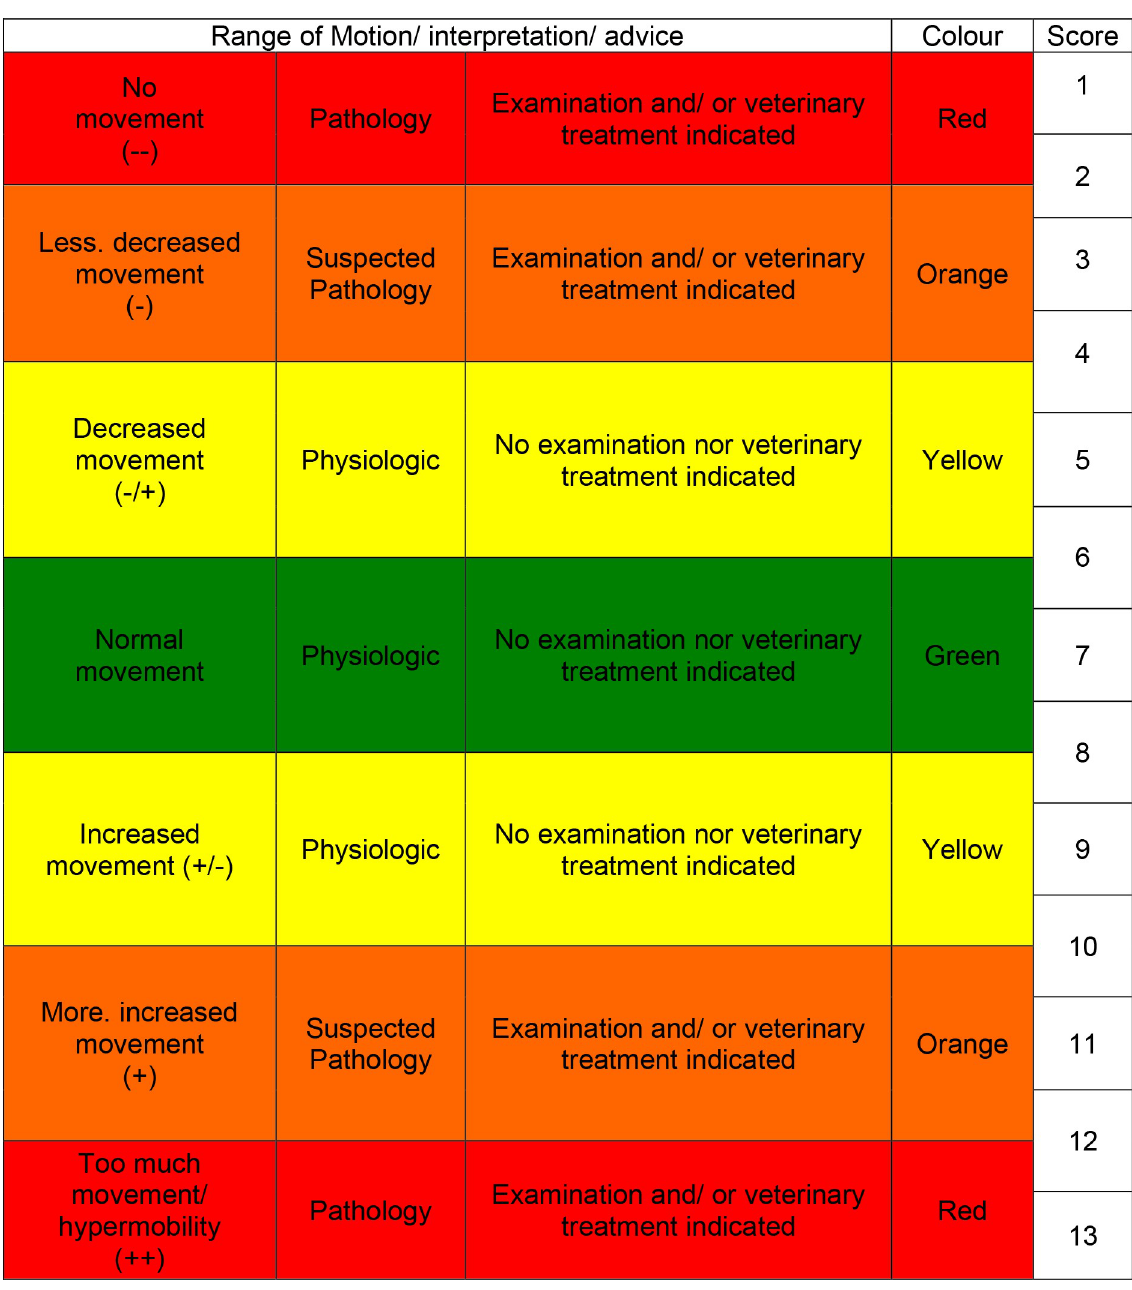
Fig 3. Colour scheme used to grade back mobility on a 1–13 scale associated with range of motion. The interpretation of the grades is given in terms of existence of pathology and in clinical terms with respect to the need to take action. https://doi.org/10.1371/journal.pone.0252536.g003 observer rated the mobility as slight aphysiological, 2 and 12 and moderate aphysiological and 1 and 13 as severe aphysiological (S1 Fig). Only one box per parameter could be ticked. Nine parameters of back mobility were evaluated: general mobility (GenMob), thoracic flexion (ThorFlex), thoracic extension (ThorExt), lumbar flexion (LumbFlex), lumbar extension (LumbExt), lumbosacral flexion (LumbSacFlex), lumbosacral extension (LumbSacExt), left